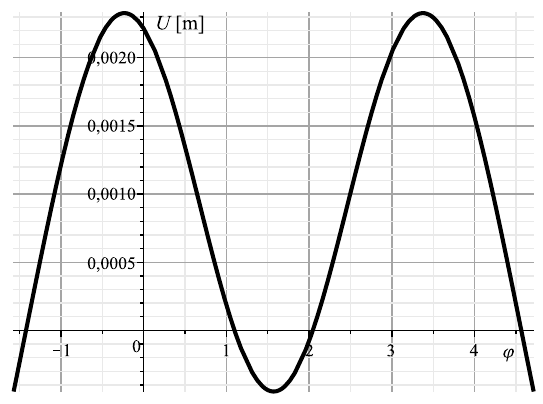
Figure 32: Plot of U ( φ ) (Example 5.4).